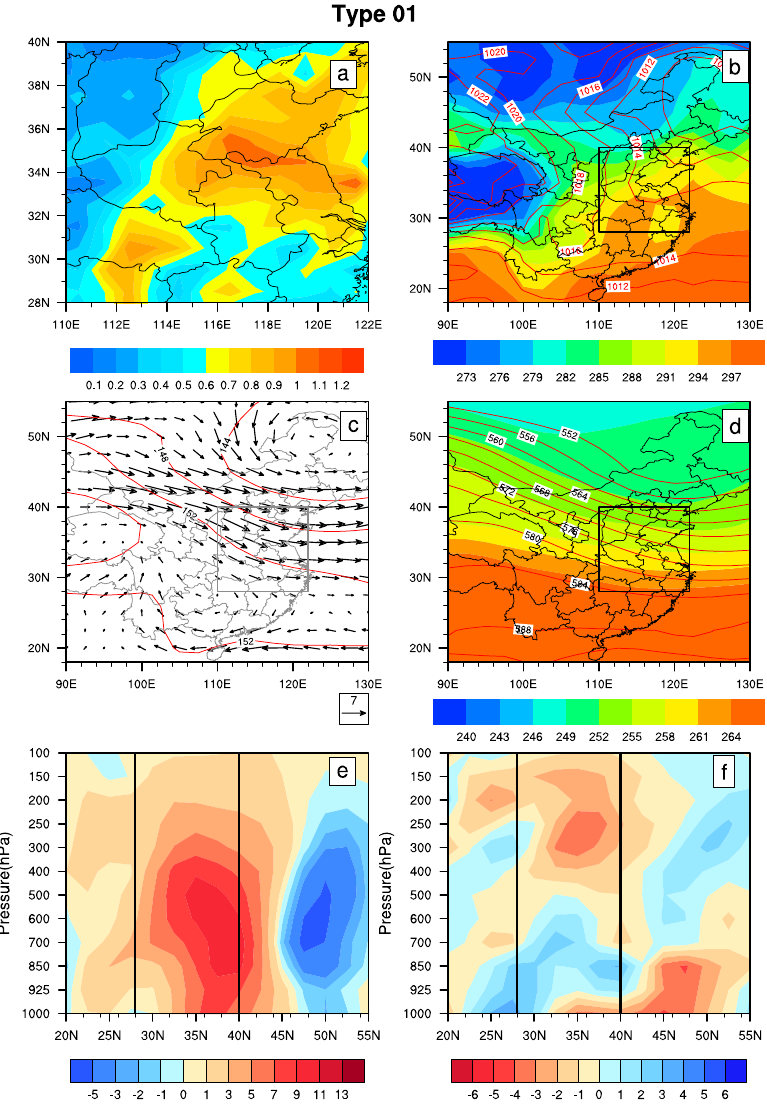
Figure 8. Type 1 (polluted). (a) The distribution of AOD over eastern China, (b) sea level pressure (red line) and temperature (colour shades) fields, (c) 850hPa wind field and geopotential height (red line) fields, (d) 500hPa temperature (colour shades) and geopotential height (red line) fields, (e) height–latitude cross-sections of vertical velocity (10 − 2 Pas − 1 ), and (f) divergence of winds (10 − 6 s − 1 ) averaged from longitude of 110–122 ◦ E. Note: black rectangular region represents eastern China (110–122 ◦ E, 28–40 ◦ N).